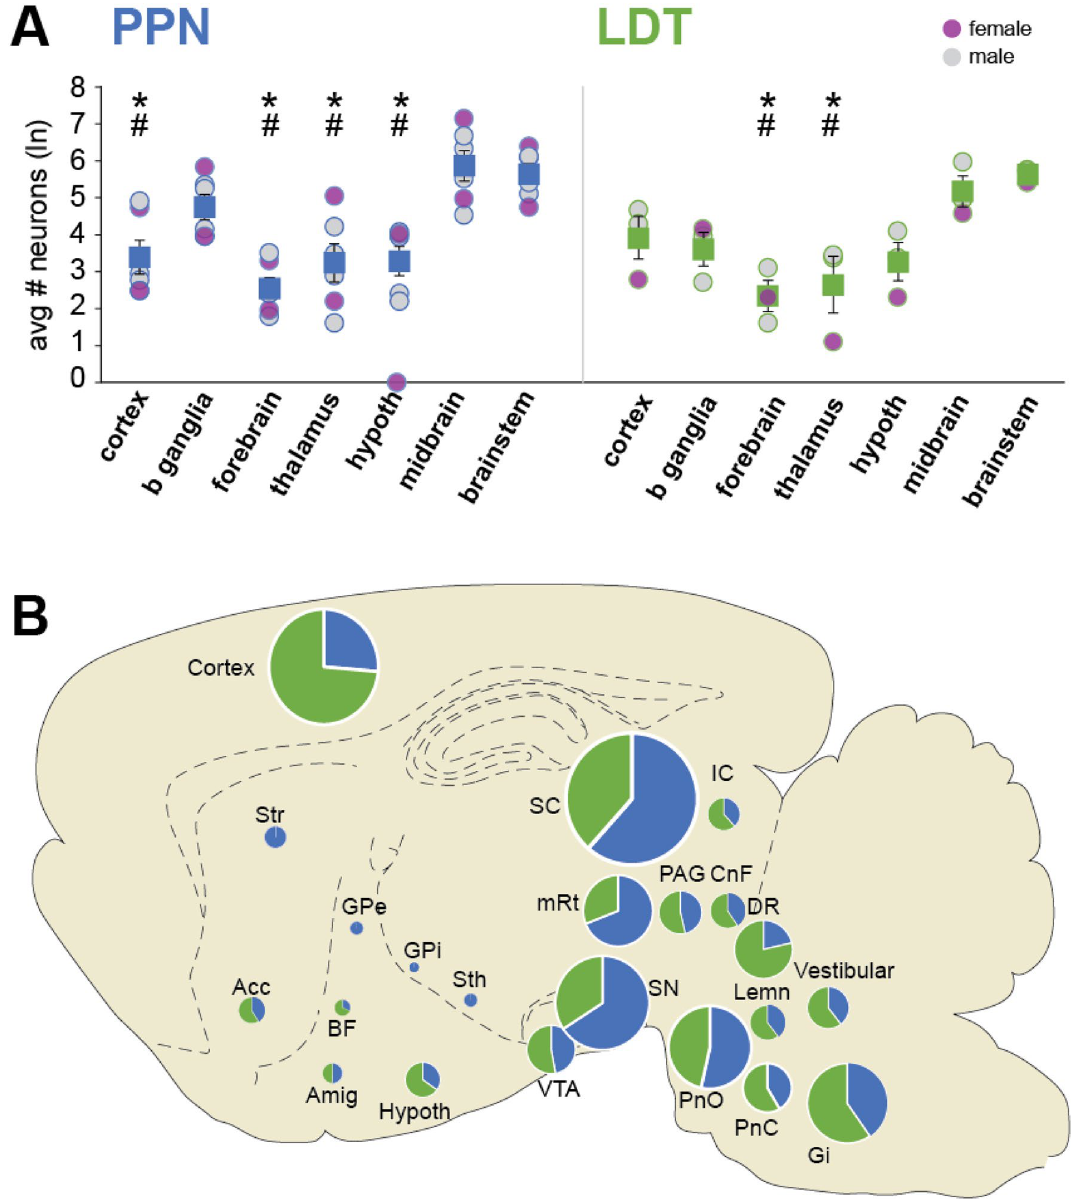
Figure 2. Afferents to PPN and LDT cholinergic neurons are heterogeneously distributed across brain regions. ( A )Average number (natural logarithm [ln], mean ± SEM) and individual subject values of input neurons (PPN n = 6 rats; LDT n = 3 rats) grouped by anatomical region, representing the cortex, basal ganglia, forebrain, thalamus, hypothalamus, midbrain and brainstem (see Fig. 3 for the list of structures that were grouped in each major region). Input neurons were more concentrated in the midbrain and brainstem for both PPN and LDT, and in the basal ganglia for the PPN. *, significant when compared to midbrain; #, significant when compared to brainstem. ( B ) Summary schematic illustrating the distribution of input neurons across the brain. The pie charts show the percentage of neurons projecting to the PPN or LDT, whereas the size of the chart shows the relative strength of this connection as estimated by the number of neurons. See list of abbreviations in Table